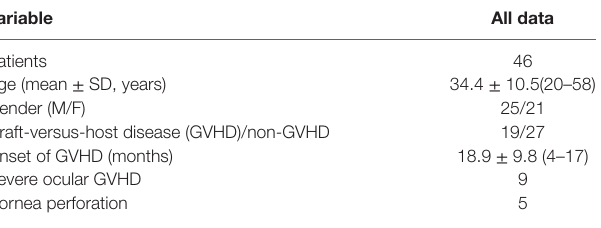
Table 2 | characteristics of patients receiving allogeneic hematopoietic stem cell transplantation. Variable all